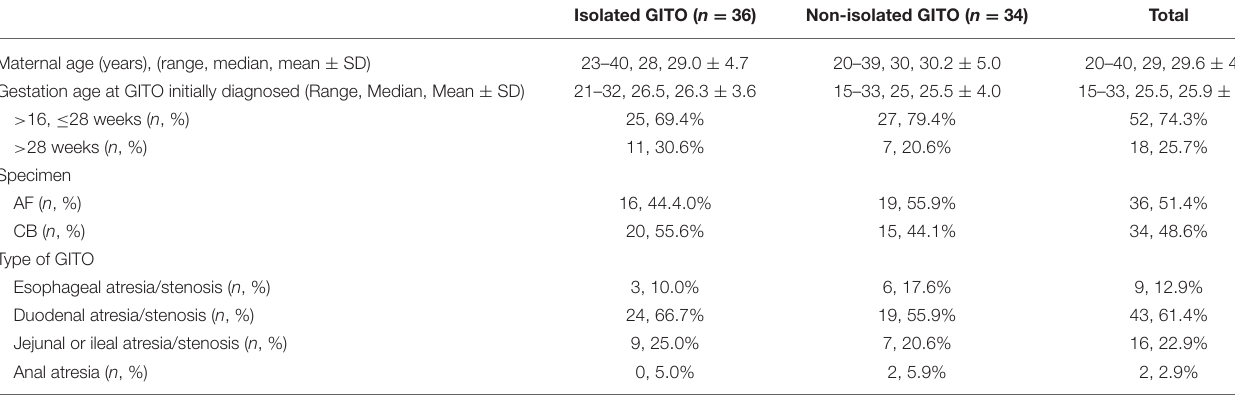
TABLE 1 | Demographic characters for 70 pregnancies with fetal gastrointestinal tract obstruction (GITO).